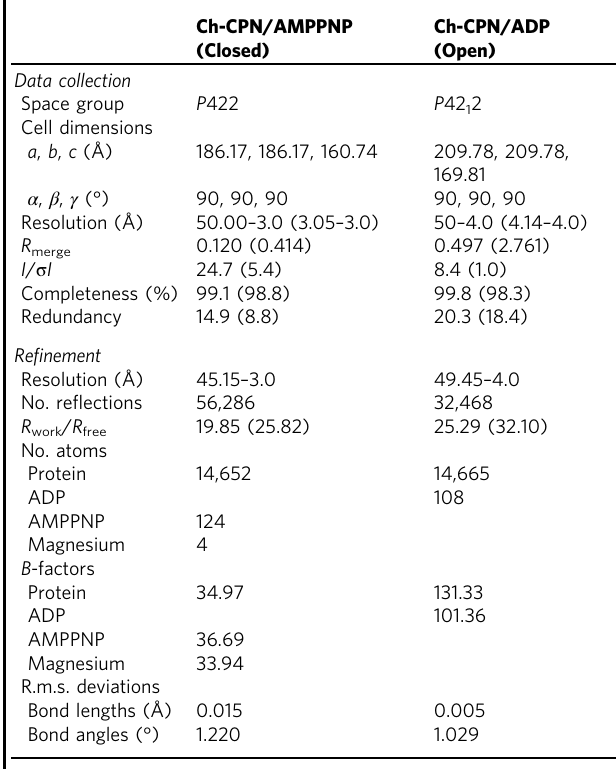
Table 1 Data collection and re fi nement statistics